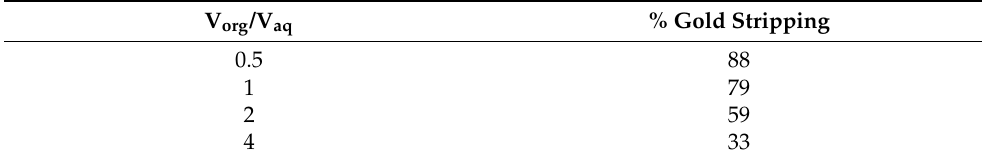
Table 11. Gold stripping under various V org /V aq ratios.